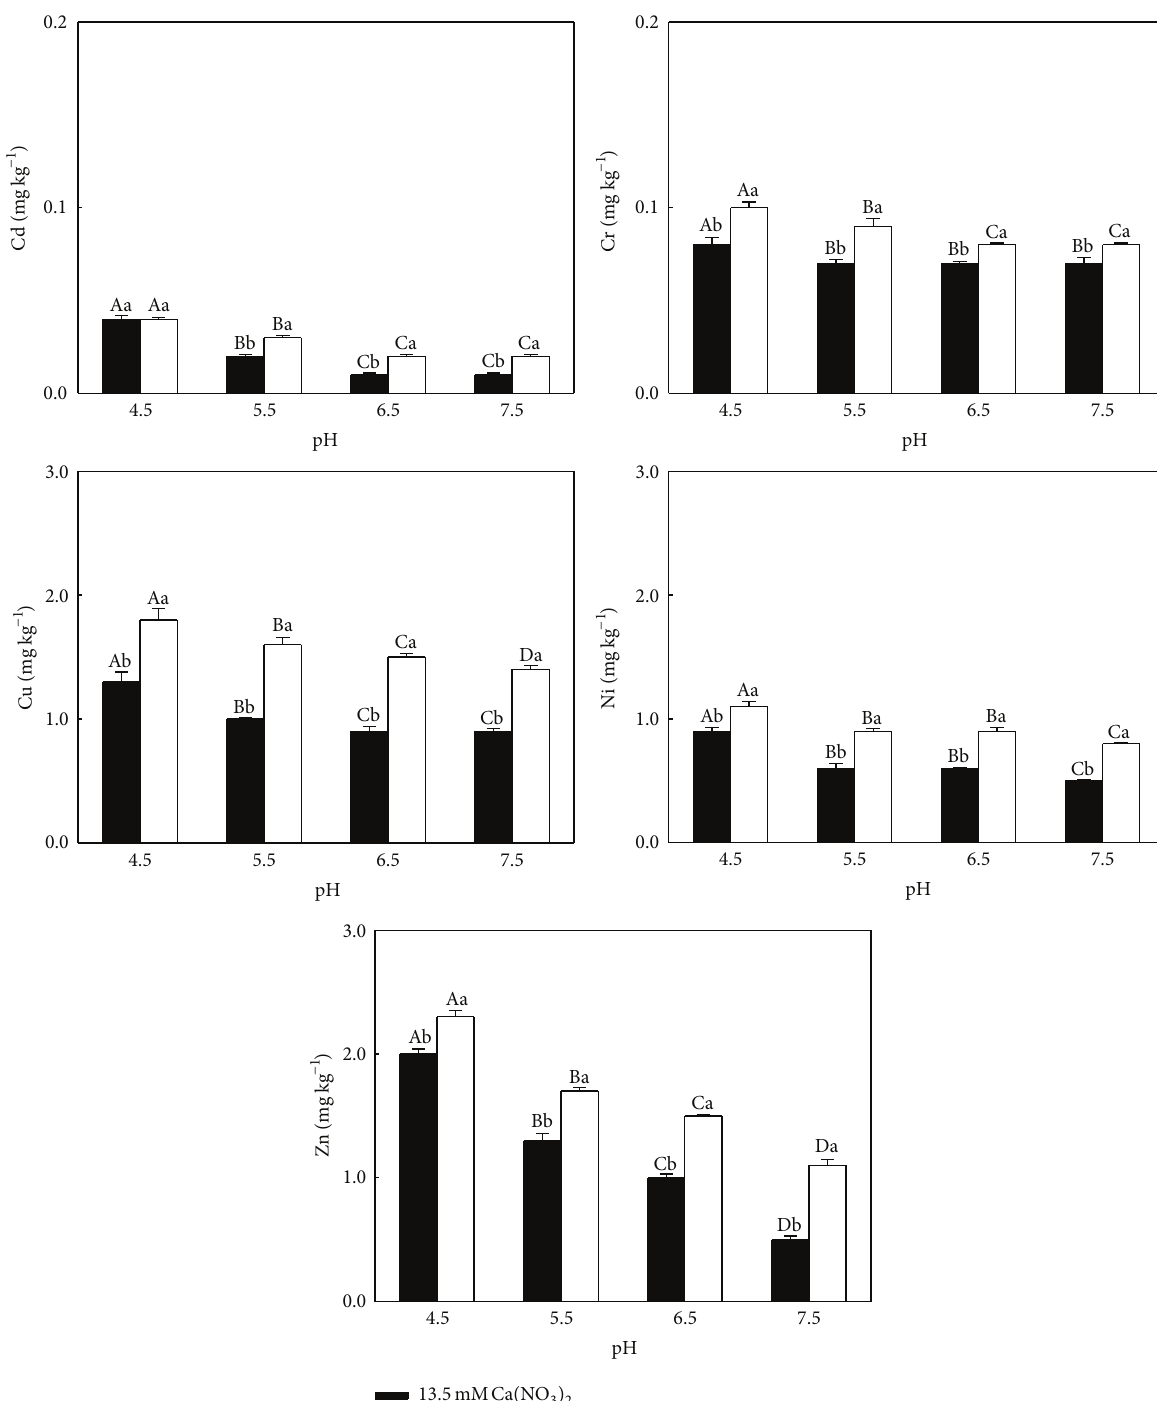
Figure 2: Effects of pH on the extraction of metals (four replicates) in biosolid-treated Romona soil (135Mg ha −1 ) by 13.5 mM Ca(NO 3 ) 2 electrolyte solution and 0.01 M organic acid mixtures. The differences of metal concentrations among the pH values were tested by one-way ANOVA. Values followed by the same uppercase letter were not significantly different at 𝑃 < 0.05 . The differences of the metal concentrations between 13.5 mM Ca(NO 3 ) 2 and 0.01 M OA mixture were tested by Student-Newman-Keuls test. Values followed by the same lowercase letter were not significantly different at 𝑃 < 0.05